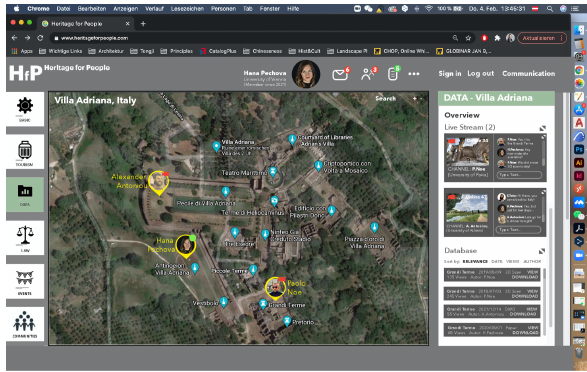
Figure 2 . Platform Example - section